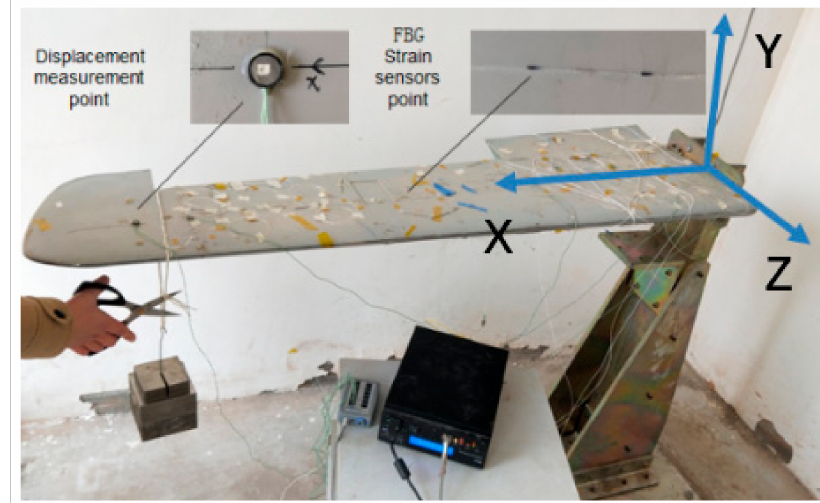
Figure 15. Dynamic load performed on the variable section wing